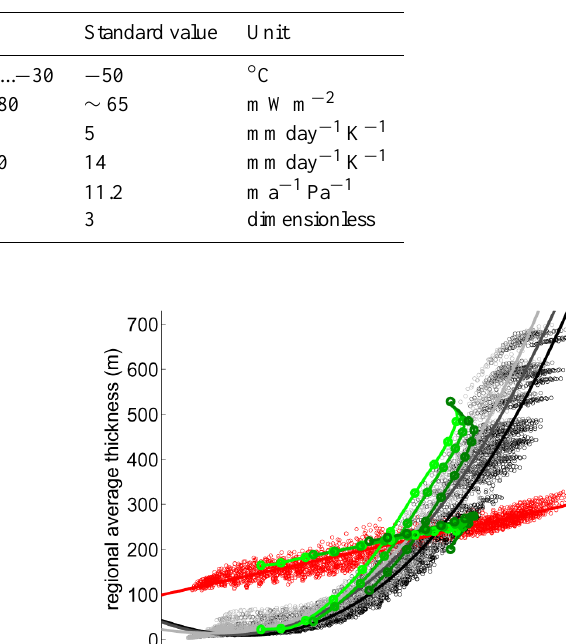
Table 1. Parameter range for ensemble experiments and standard values used in the simulations above. Heat flux is non-uniform in the standard experiment. One experiment for every possible permutation of the above parameters has been carried out, for two different climate forcings, giving a total of 15552 model simulations (see Fig. 9).